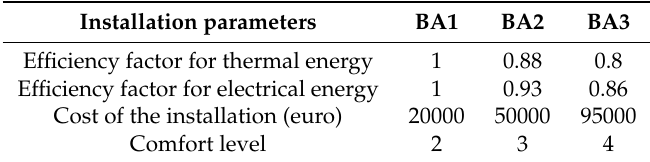
Table A5. Installation parameters—building automation control